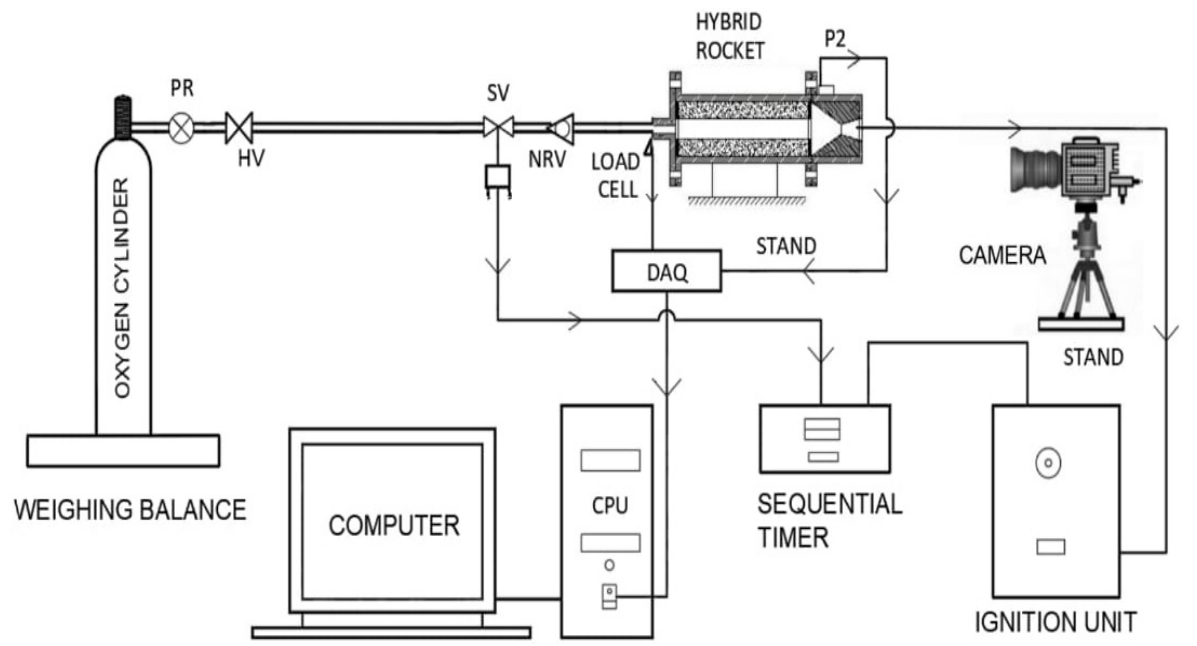
Figure 4. Schematic diagram of the oxygen feed line set up for the ballistic test.